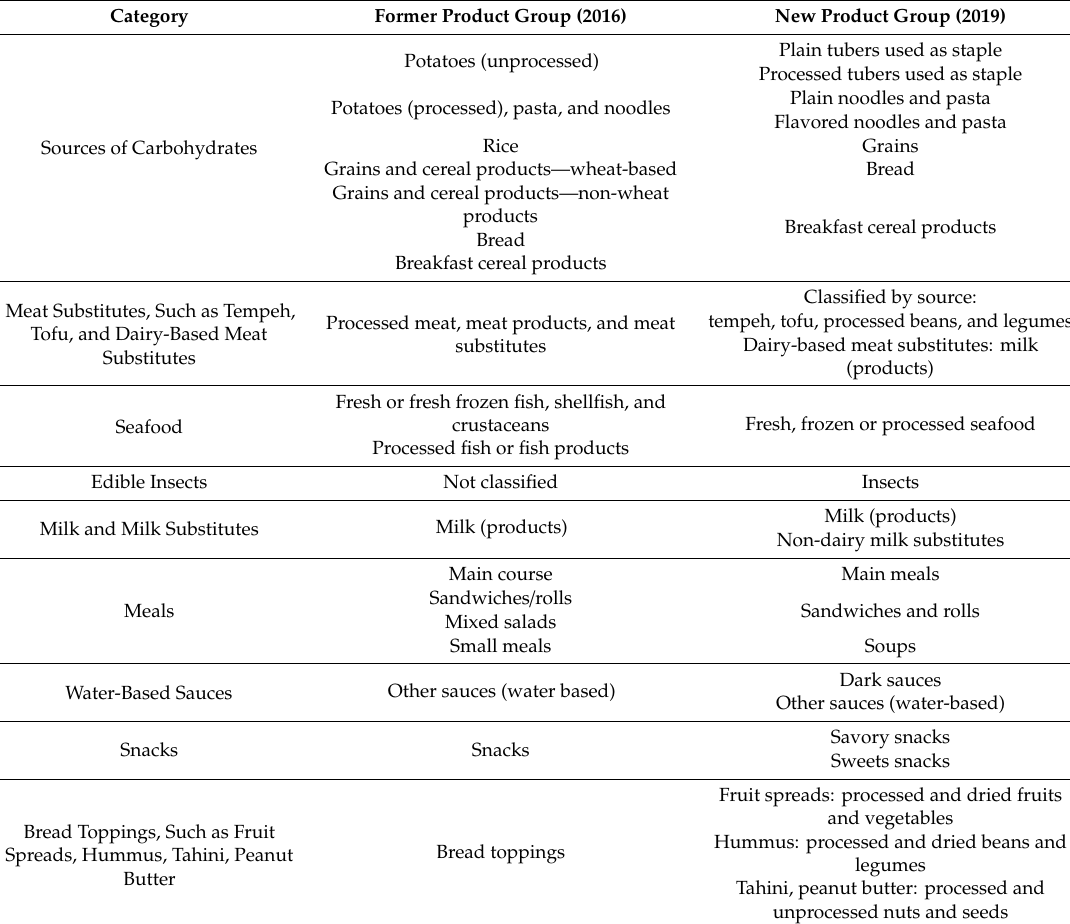
Table 3. Results of product group classification